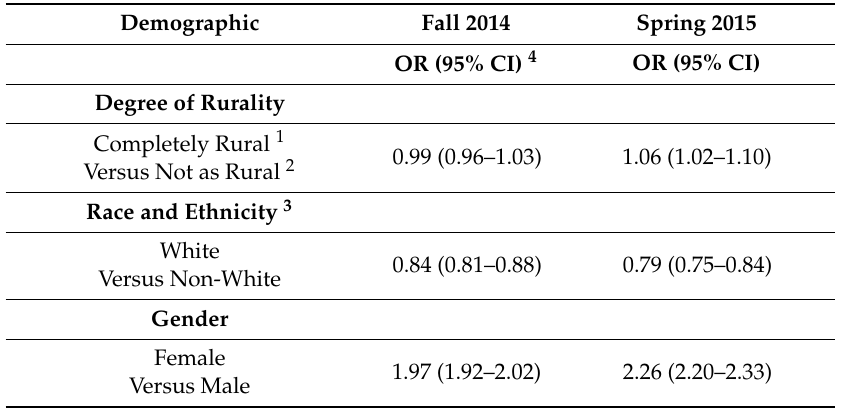
Table 3. Relationship between demographics of students and more versus less healthful entr é e purchases in the fall and spring